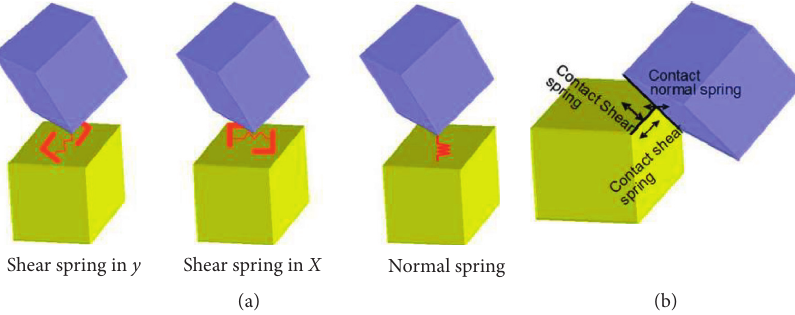
Figure 2: Different types of element contacts. (a) Corner-to-face or corner-to-ground contact. (b) Edge-to-edge contact [9].